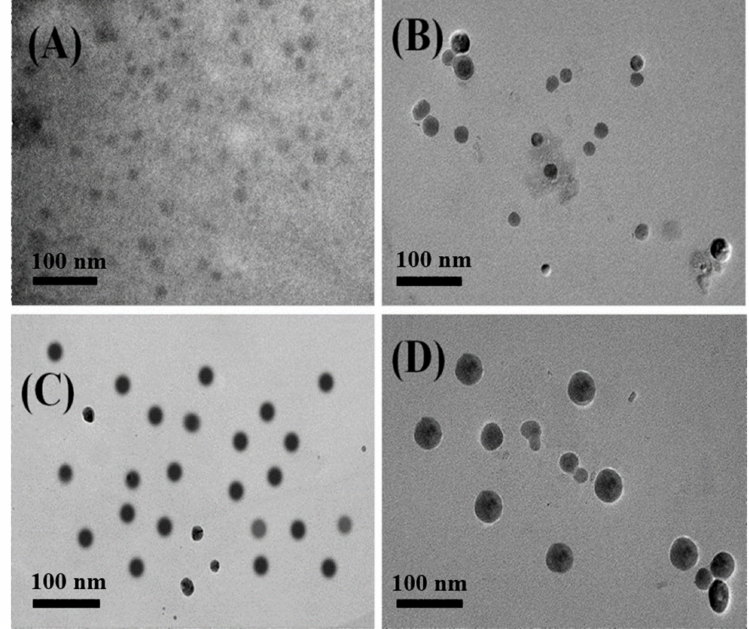
Figure 2. TEM images of di ff erent micelles obtained from P(MQ-co-NIPAM)-b-PS assembly: M6-1 ( A ), M6-2 ( B ), M6-3 ( C ), and M6-4 ( D